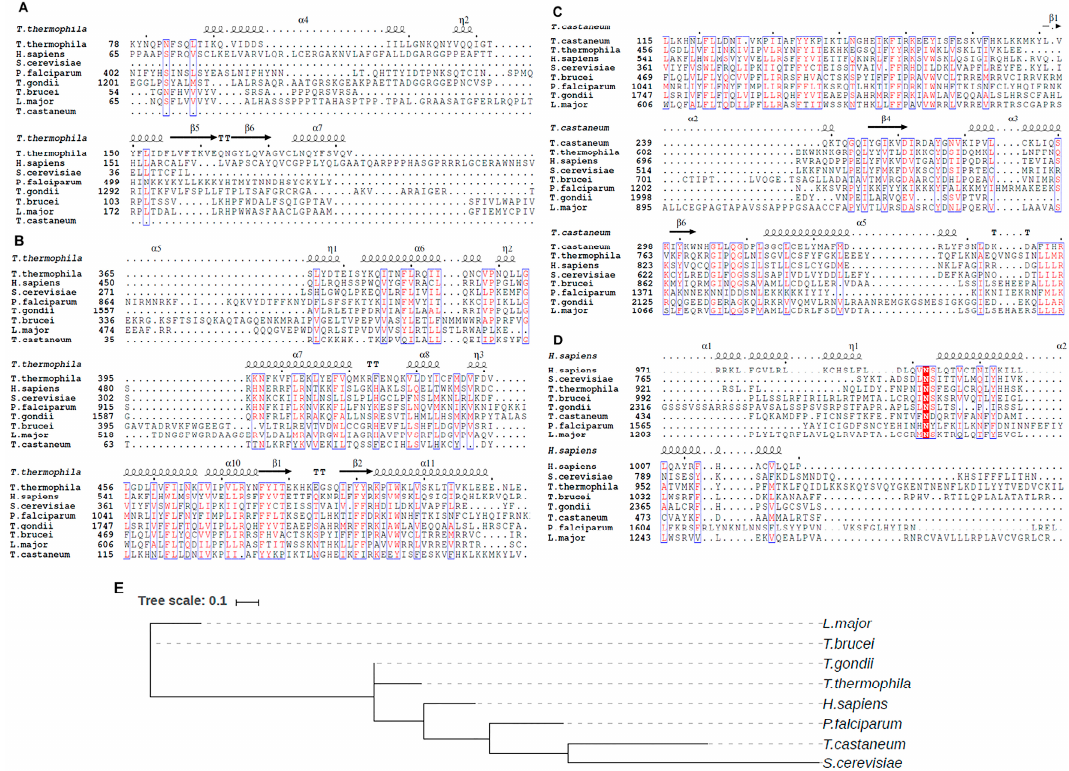
Figure 2. Sequence Alignment showing the conserved residues of TERT between T. thermophila , H. sapiens , S. cerevisiae , P. falciparum , T. gondii , T. brucei , L. major , T. castaneum for selected regions of (A) TEN domain (B) TRBD domain (C) RT domain and (D) CTE domain. The upper row in each alignment represents the secondary structure adopted by the domain in particular species where α -helix is represented as coil, β -sheet as arrows and β -turns as TT. Dots between the secondary structure elements or sequence alignment represent the deletion of residues/regions in species. Every 10th amino acid residue in the sequence is represented by a bold dot on the top. Red shaded regions represent the highly conserved residue across the species. (E) Phylogenetic tree between the TERT sequences of T. thermophila , H. sapiens , S. cerevisiae , T. brucei , T. gondii , P. falciparum , T. castaneum , L. major . T. brucei being ancestral eukaryote believed to have primitive TERT sequence from which TERT of L. major and other species evolved. Each species in the phylogenetic tree is connected to its branch through dashed line.